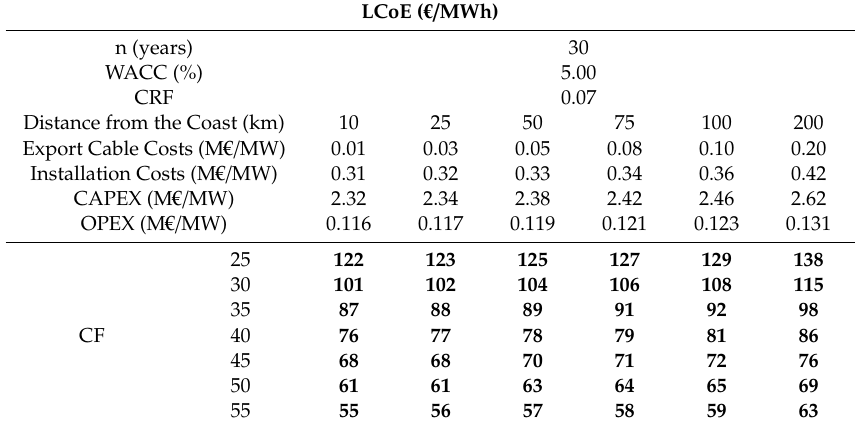
Table 2. LCoEs (in bold in the table) calculated as function of CAPEX, OPEX and CF. WACC equal to 5%.